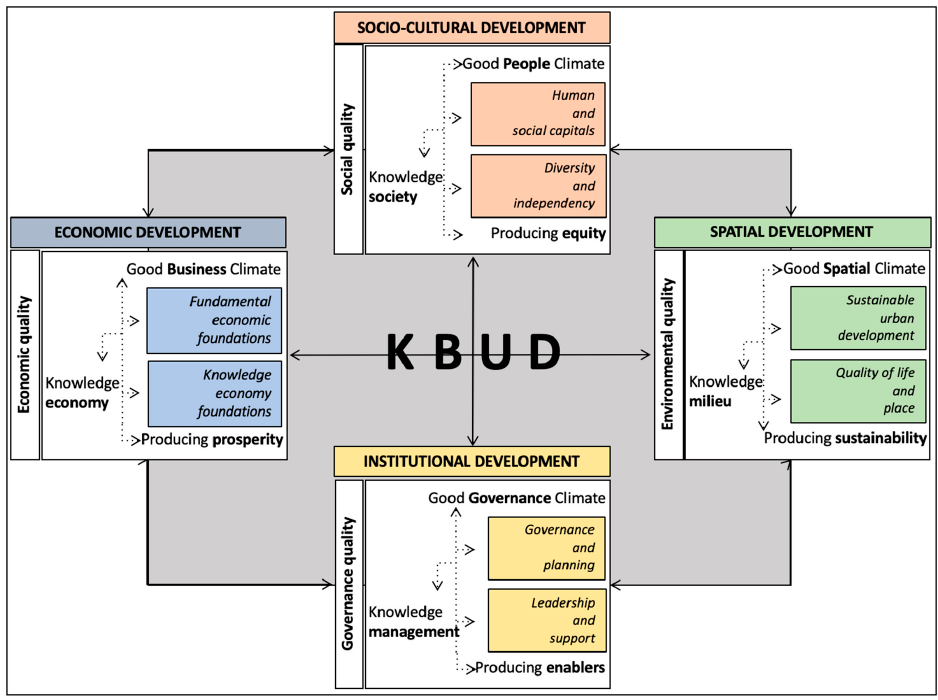
Figure 2. Conceptual framework of knowledge-based urban development (KBUD), derived from Reference [46]. Table 2. Five-what and five-how discussion starter questions.